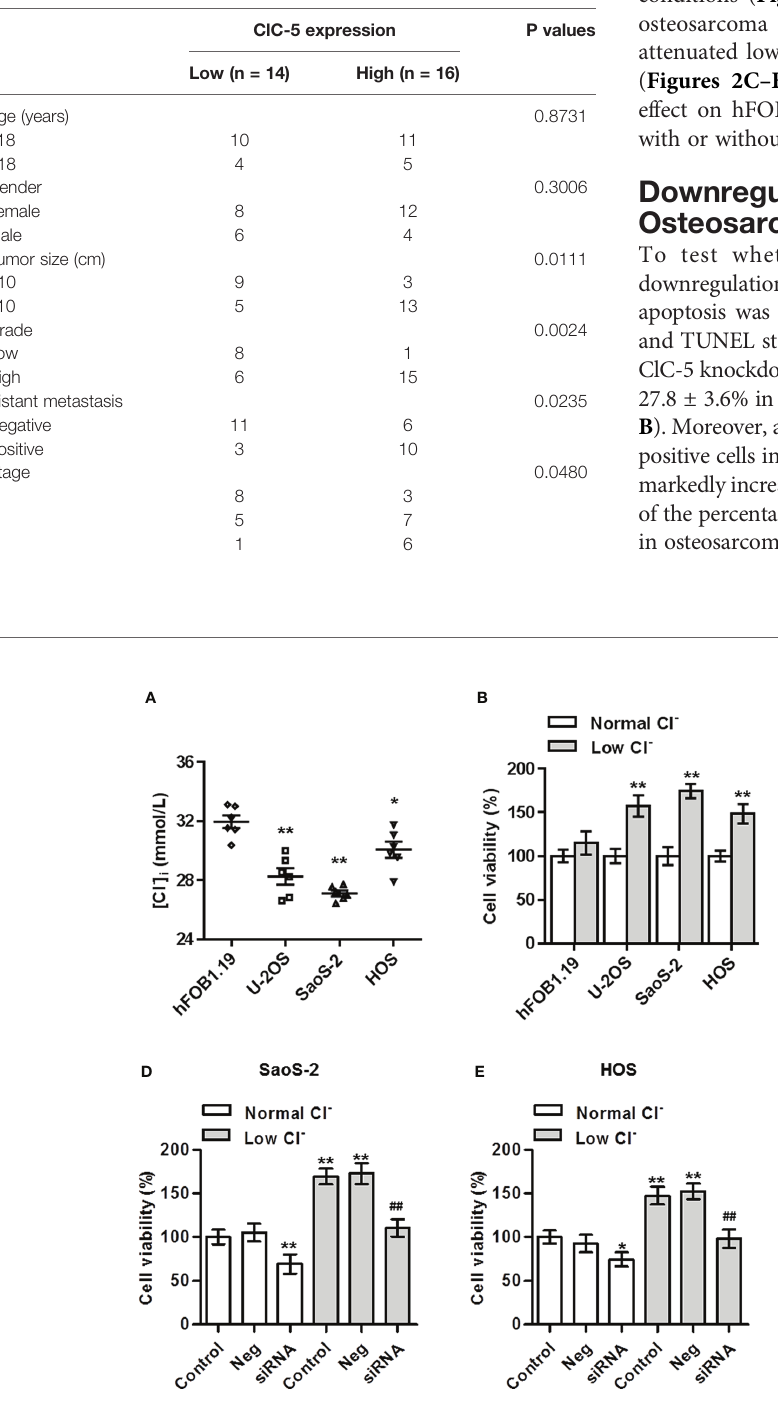
TABLE 1 | Relationship between ClC-5 expression and the clinical characteristics of the osteosarcoma patients.